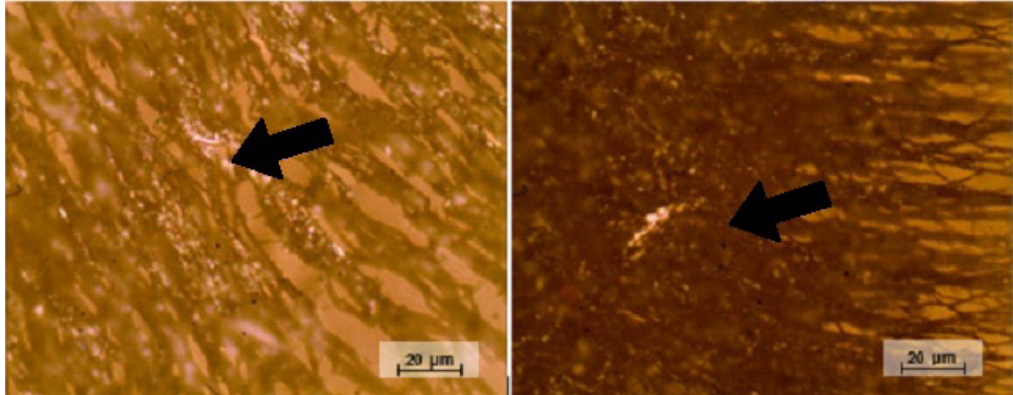
Figure 10. Contaminated blade with 2% left and 5% right. Source: Author’s own elaboration.